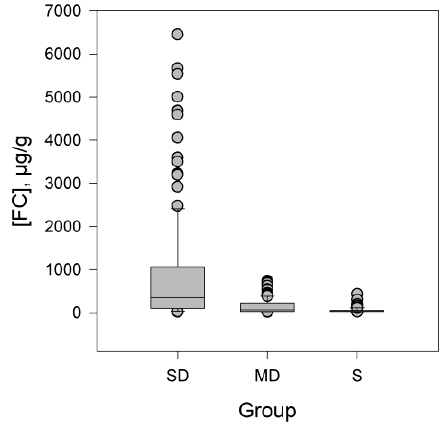
( B ) patients. Red, blue and green points correspond to SD, MD and S vitamin D level, respectively.